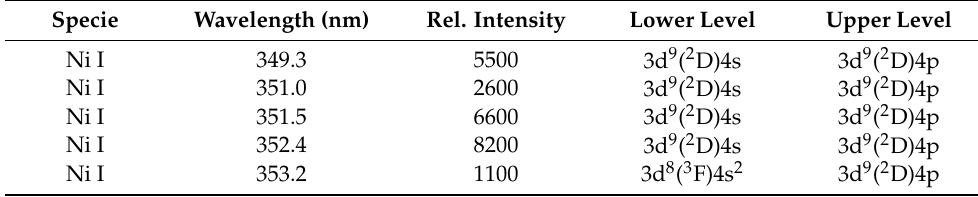
Figure 5. OES spectrum of plasma registered and fitted with basic components during the sputtering of nickel target ( a ) and collection of OES spectra registered at various temperatures ( b ). Table 2. OES lines attributed to the measured spectra